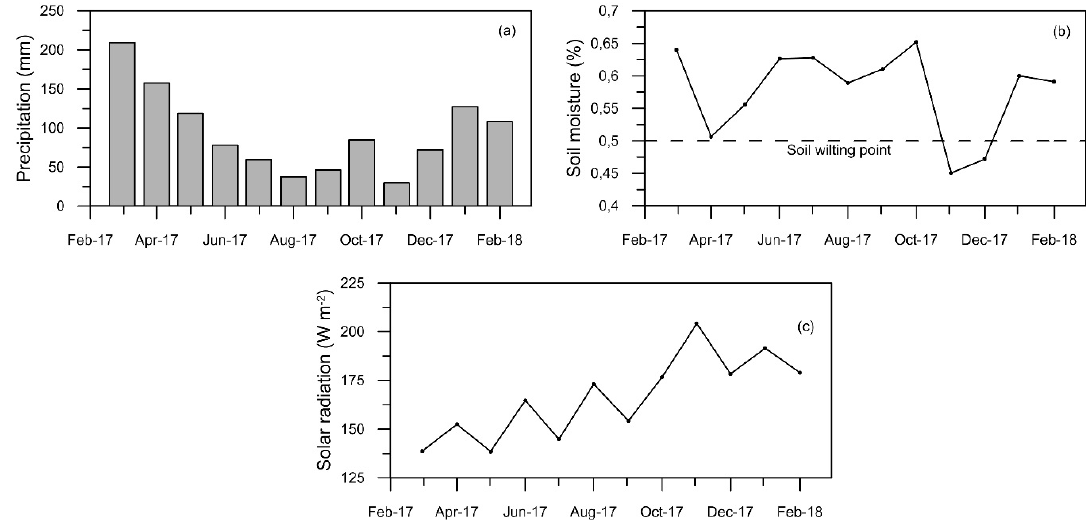
Figure 5. ( a ) Total monthly precipitation, ( b ) monthly average soil moisture, and ( c ) monthly average